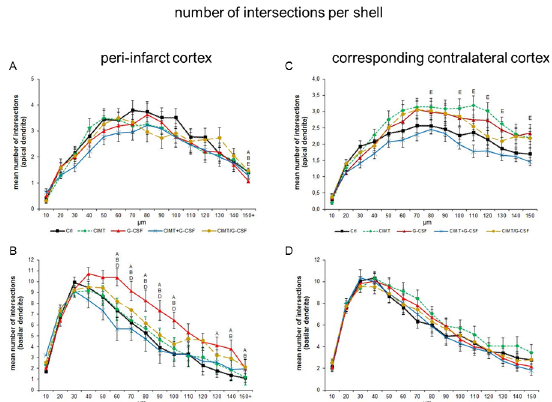
Fig 6. Sholl analysis of Golgi Cox-impregnated layer V pyramidal neurons in the peri-infarct cortex and in the corresponding contralateral cortex. Note that corresponding to the increased length of basilar dendrites (c.f. Fig 3) a significantly increased number of intersections of higher order in the G-CSF group of the peri-infarct cortex were detectable (B) which paralleled the functional outcome as recently published [6] (A, B, D, E significant difference compared with control, CIMT, CIMT+G-CSF, CIMT/G-CSF, respectively. Values are expressed as mean number of intersections / μ m ± SEM; p <